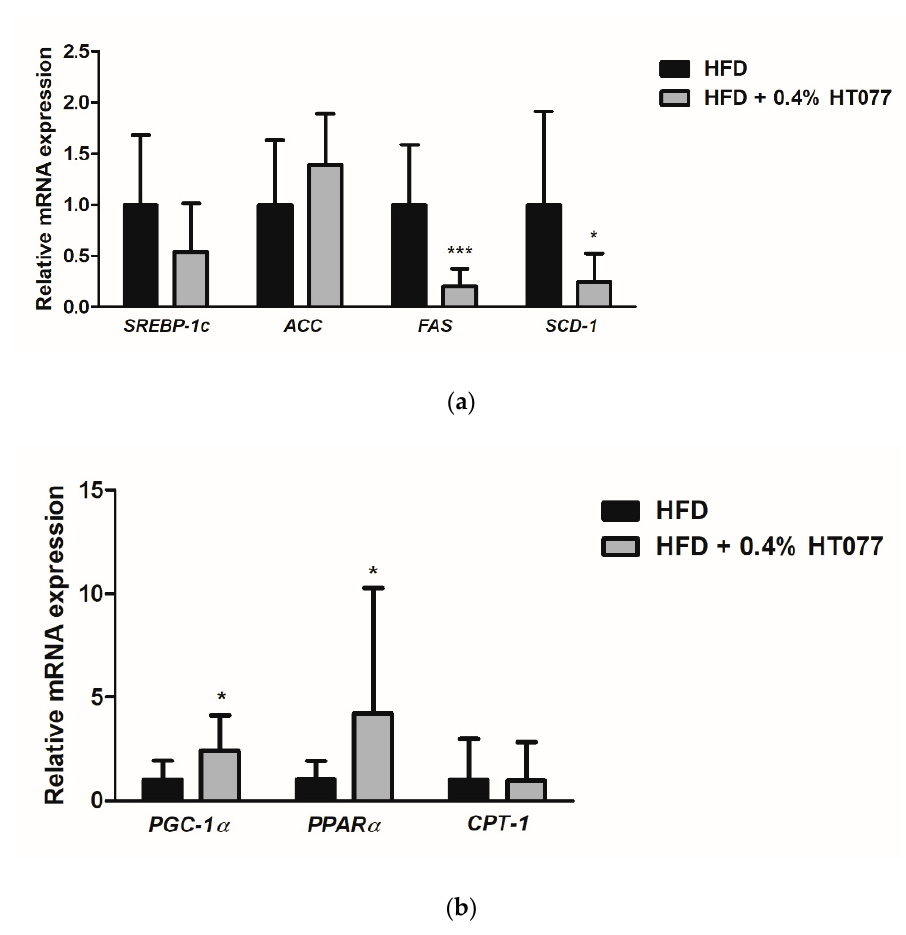
Figure 6. E ff ects of an extract mixture of Prunus persica and Nelumbo nucifera (HT077) on the expression of genes related to lipogenesis ( a ) and fatty acid oxidation ( b ) in the adipose tissue. C57BL / 6 mice received a high-fat diet (HFD) or HFD containing 0.4% HT077 for 12 weeks. The mRNA expression levels of lipogenesis-relatedgenes, includingsterolregulatoryelement-bindingprotein1c( SREBP-1c ), acetyl-CoA carboxylase ( ACC ), fatty acid synthase ( FAS ), and stearoyl-CoA desaturase-1 ( SCD-1 ), as well as fatty acid oxidation-related genes, including peroxisome proliferator-activated receptor- γ coactivator-1 α ( PGC-1 α ), peroxisome proliferator-activated receptor α ( PPAR α ), and carnitine palmitoyltransferase-1 ( CPT-1 ), were measured in the mesenteric white adipose tissue. All values are presented as the mean ± SD ( n = 16 for HFD and 12 for HFD + HT077 groups). The y -axis indicates relative